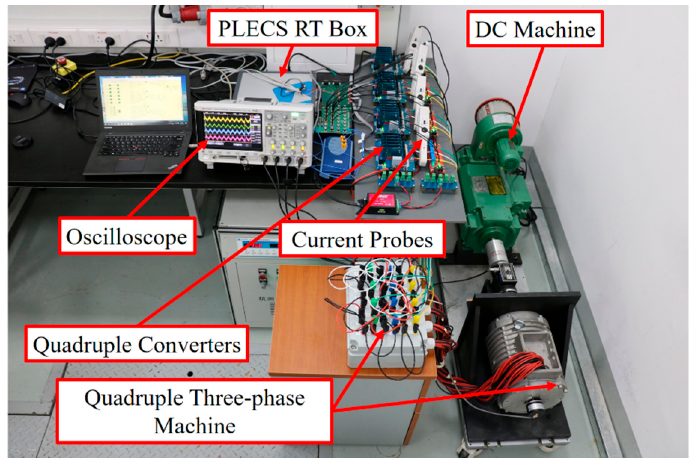
Table 1. Experimental parameters.